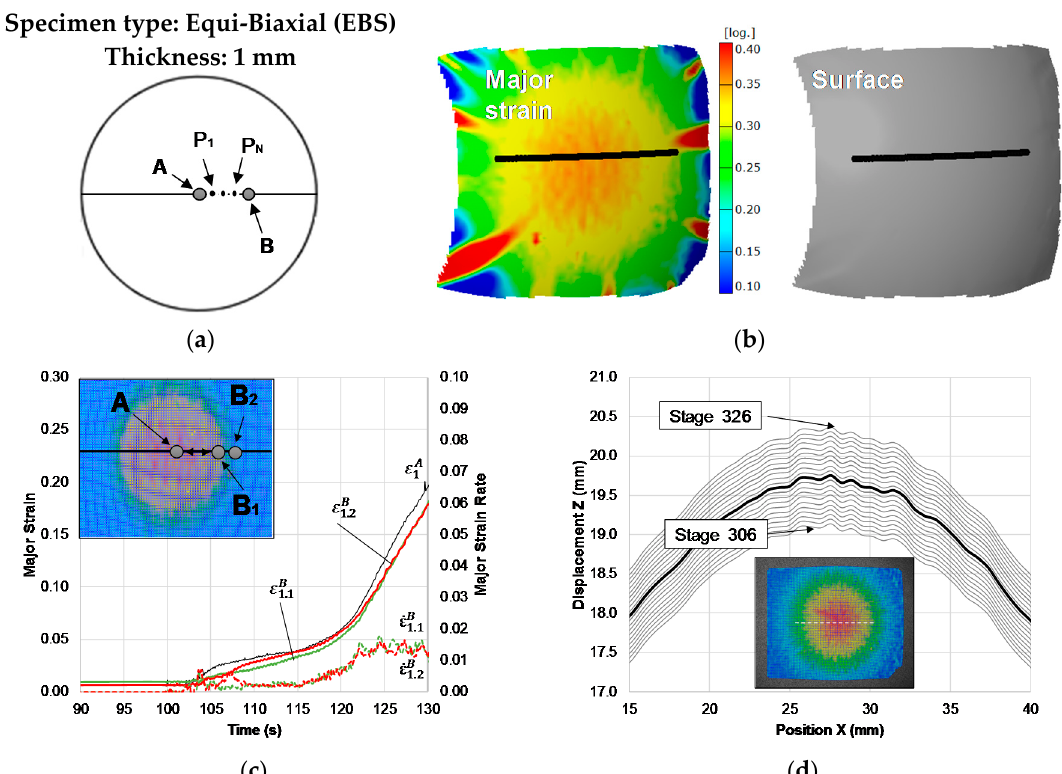
Figure 5. Application of the methodology to obtain the onset of necking strains for an Equi-biaxial strain (EBS) Nakajima specimen of PC with 1 mm of thickness. ( a ) The geometry of the specimens and identification of the section perpendicular to the failure region and selected points along its length. ( b ) Major strain (left) and surface shape (right) of the specimens’ failure area obtained by the DIC system. ( c ) Experimental time evolution of the major strain along the points of the selected section. ( d ) Z-displacement along the selected section.